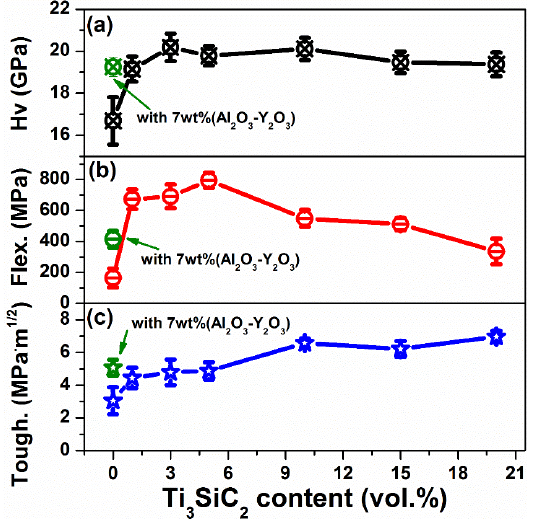
Figure 4. Mechanical properties of Ti 3 SiC 2 doped Si 3 N 4 ceramics: ( a ) Vickers hardness; ( b ) Flexural strength and ( c ) fracture toughness.